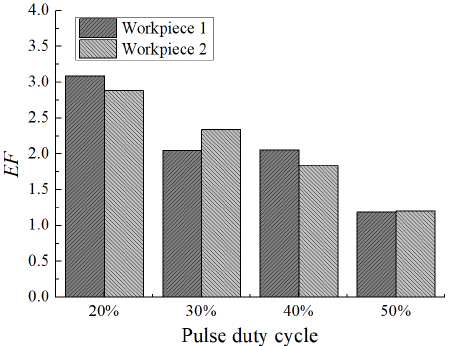
Figure 15. The EF of micro dimples generated with different pulse duty cycles.